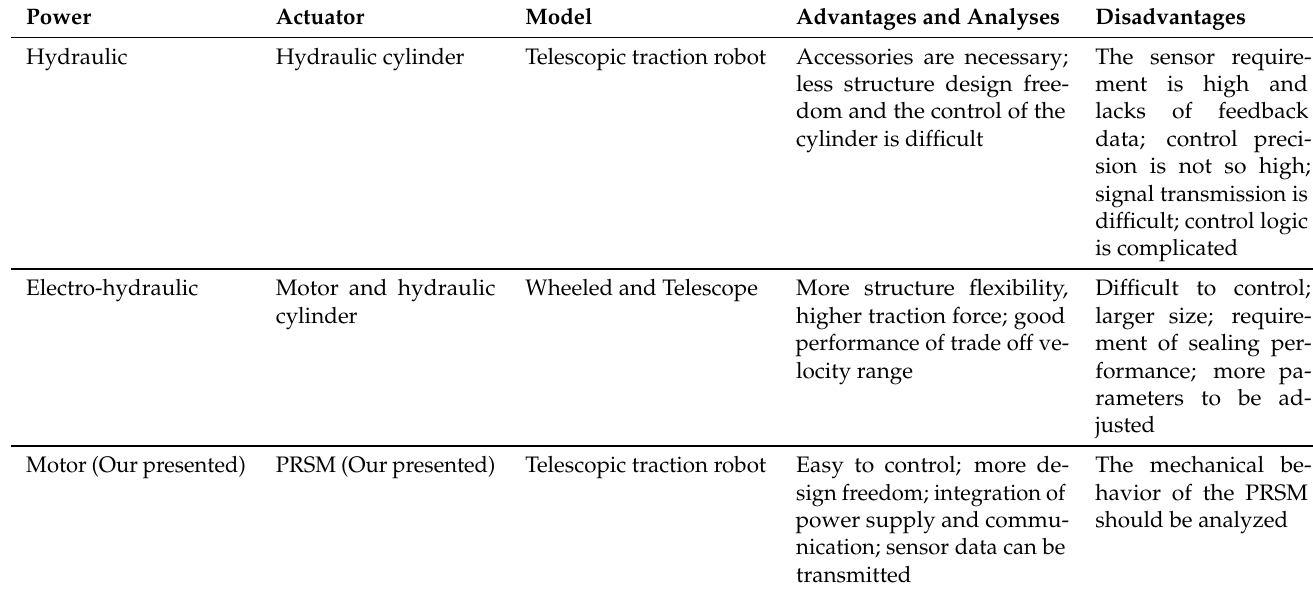
Table 1. Comparisons of two driving powers in downhole telescopic traction robot mode.